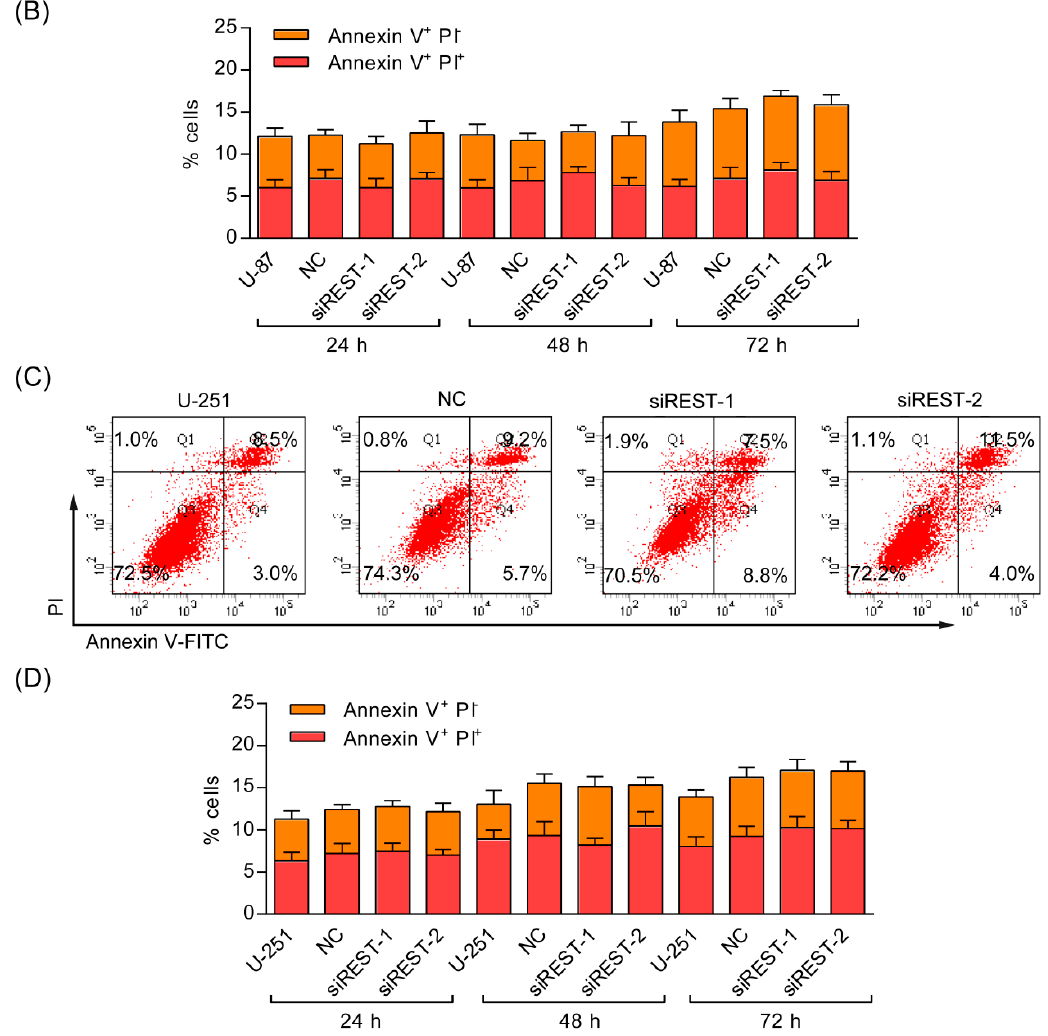
Figure 5. REST silencing does not induce cell apoptosis. ( A ) Representative cell apoptosis plots of U-87 cells at 48 h after REST knockdown; ( B ) The apoptosis of 3 independent experiments at 24, 48 and 72 h in U-87 cells; ( C ) Representative cell apoptosis plots of U-251 cells at 48 h after REST knockdown; ( D ) The apoptosis of 3 independent experiments at 24 h, 48 h and 72 h in U-251 cells.